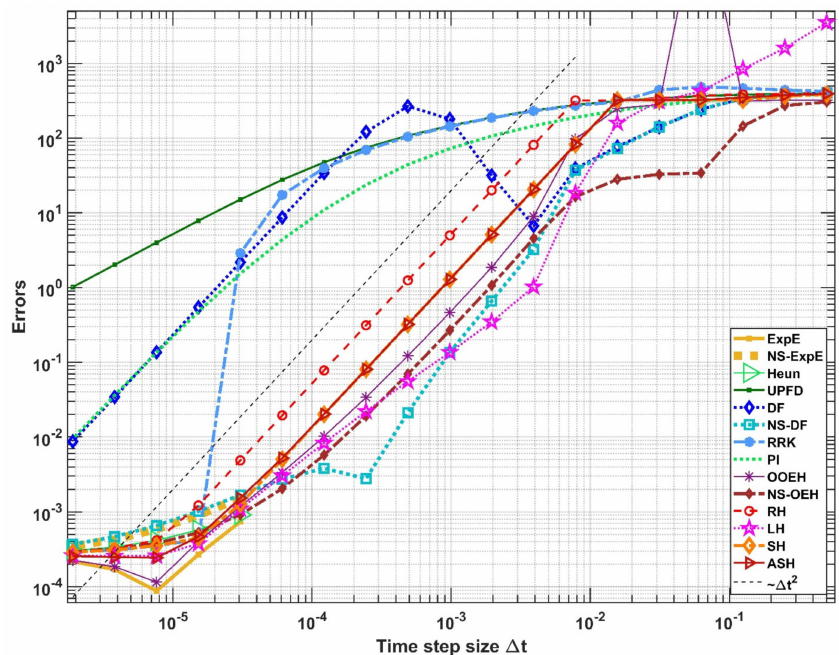
Figure 4. The L ∞ errors as a function of the time step size ∆ t for the numerical solutions of Equation (2).